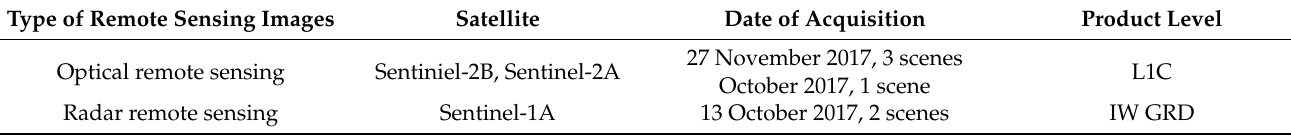
Table 1. Details of the remote sensing data with specifications and dates of